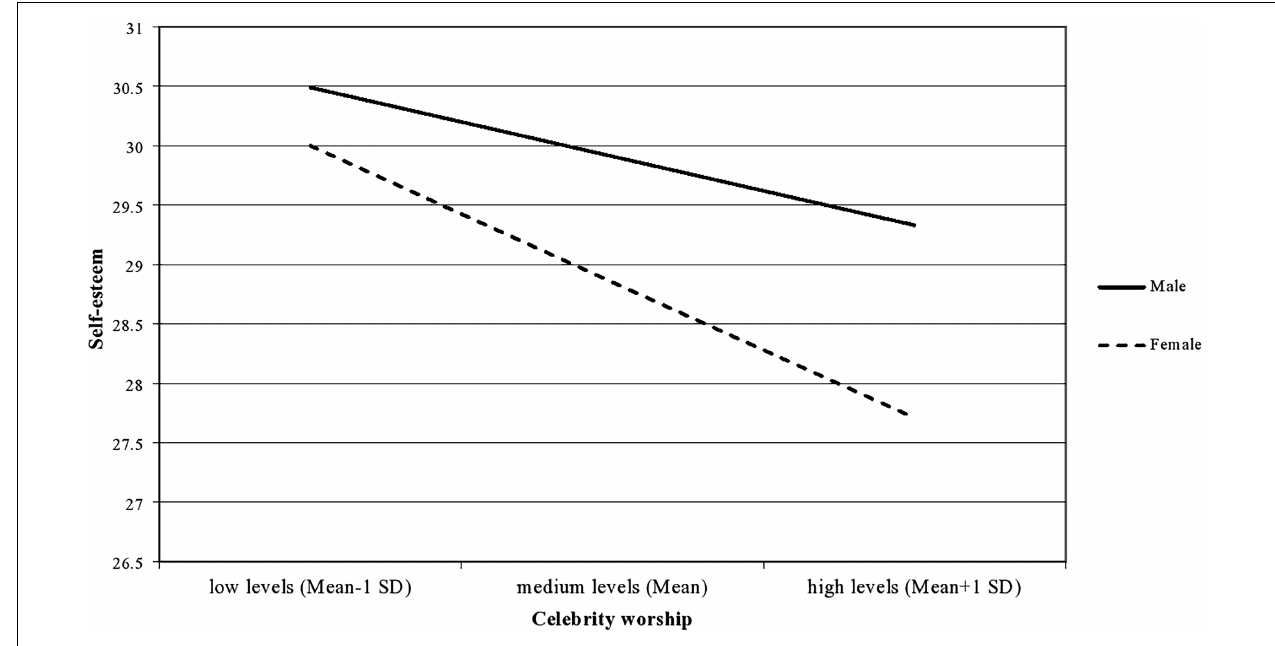
FIGURE 1 | Gender differences in the association between celebrity worship and self-esteem.